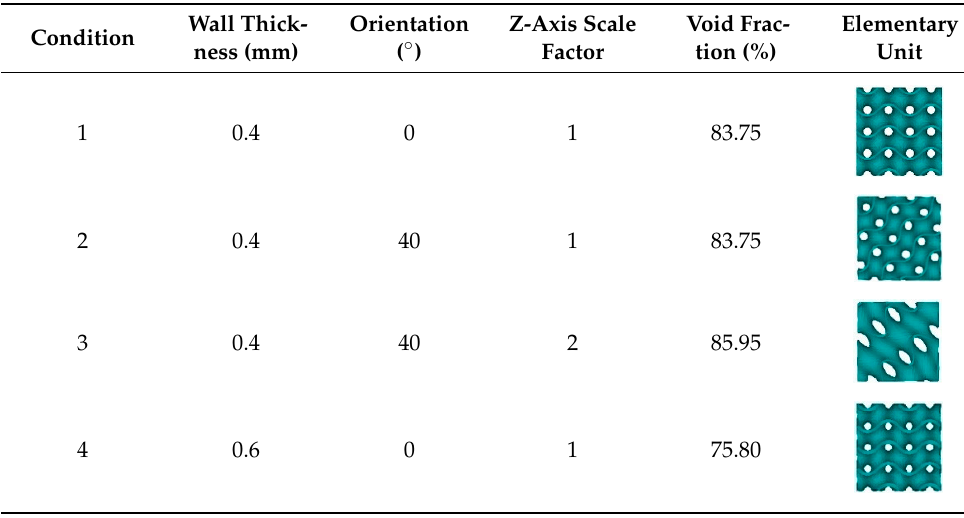
Table 1. Geometrical factors for each Table 1. Geometrical factors for each condition. Table 1. Geometrical factors for each condition. Table 1. Geometrical factors for each condition. Table 1. Geometrical factors for each condition.